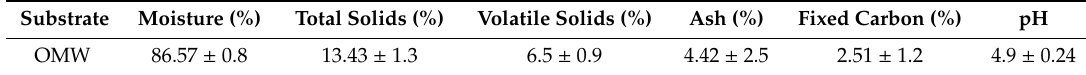
Table 1. Characterization of olive mill wastewater (OMW).